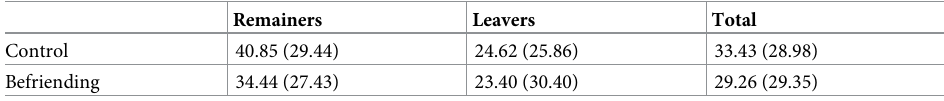
Table 1. Affective polarization scores: Descriptive statistics.